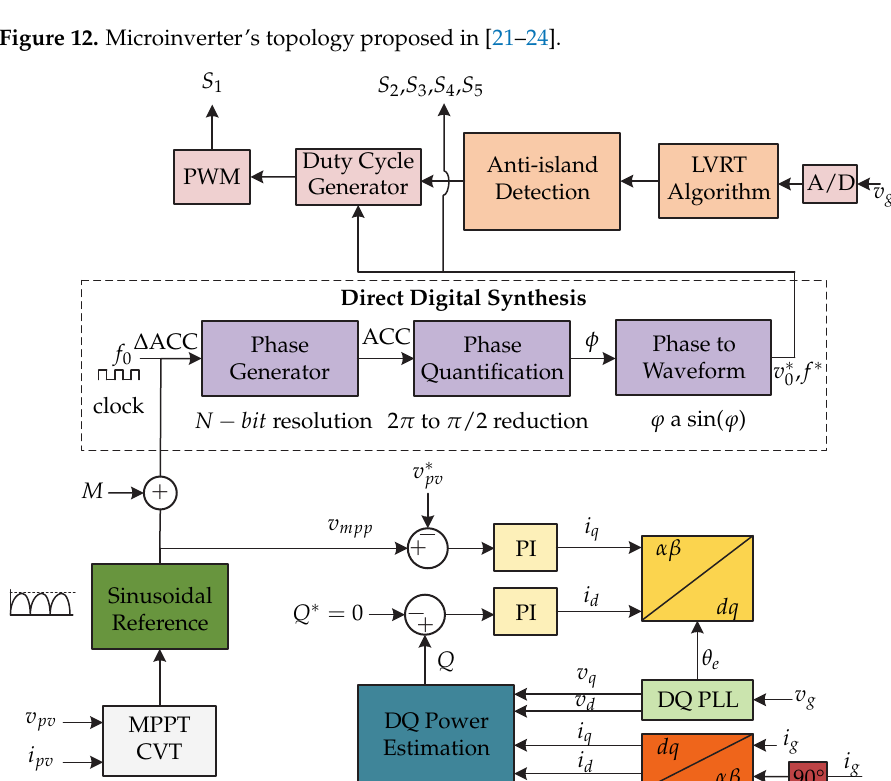
Figure 13. Control strategy proposed in [21–24].